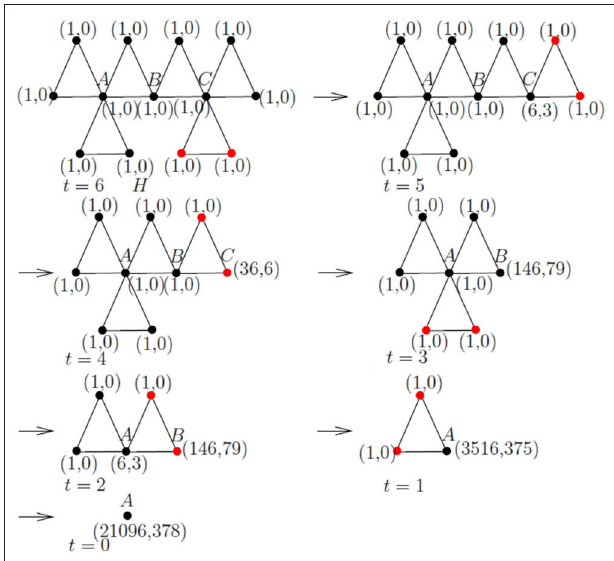
FIGURE 3 | An example of calculating the number of subtrees by Algorithm A , where two red vertices are deleted at each step.